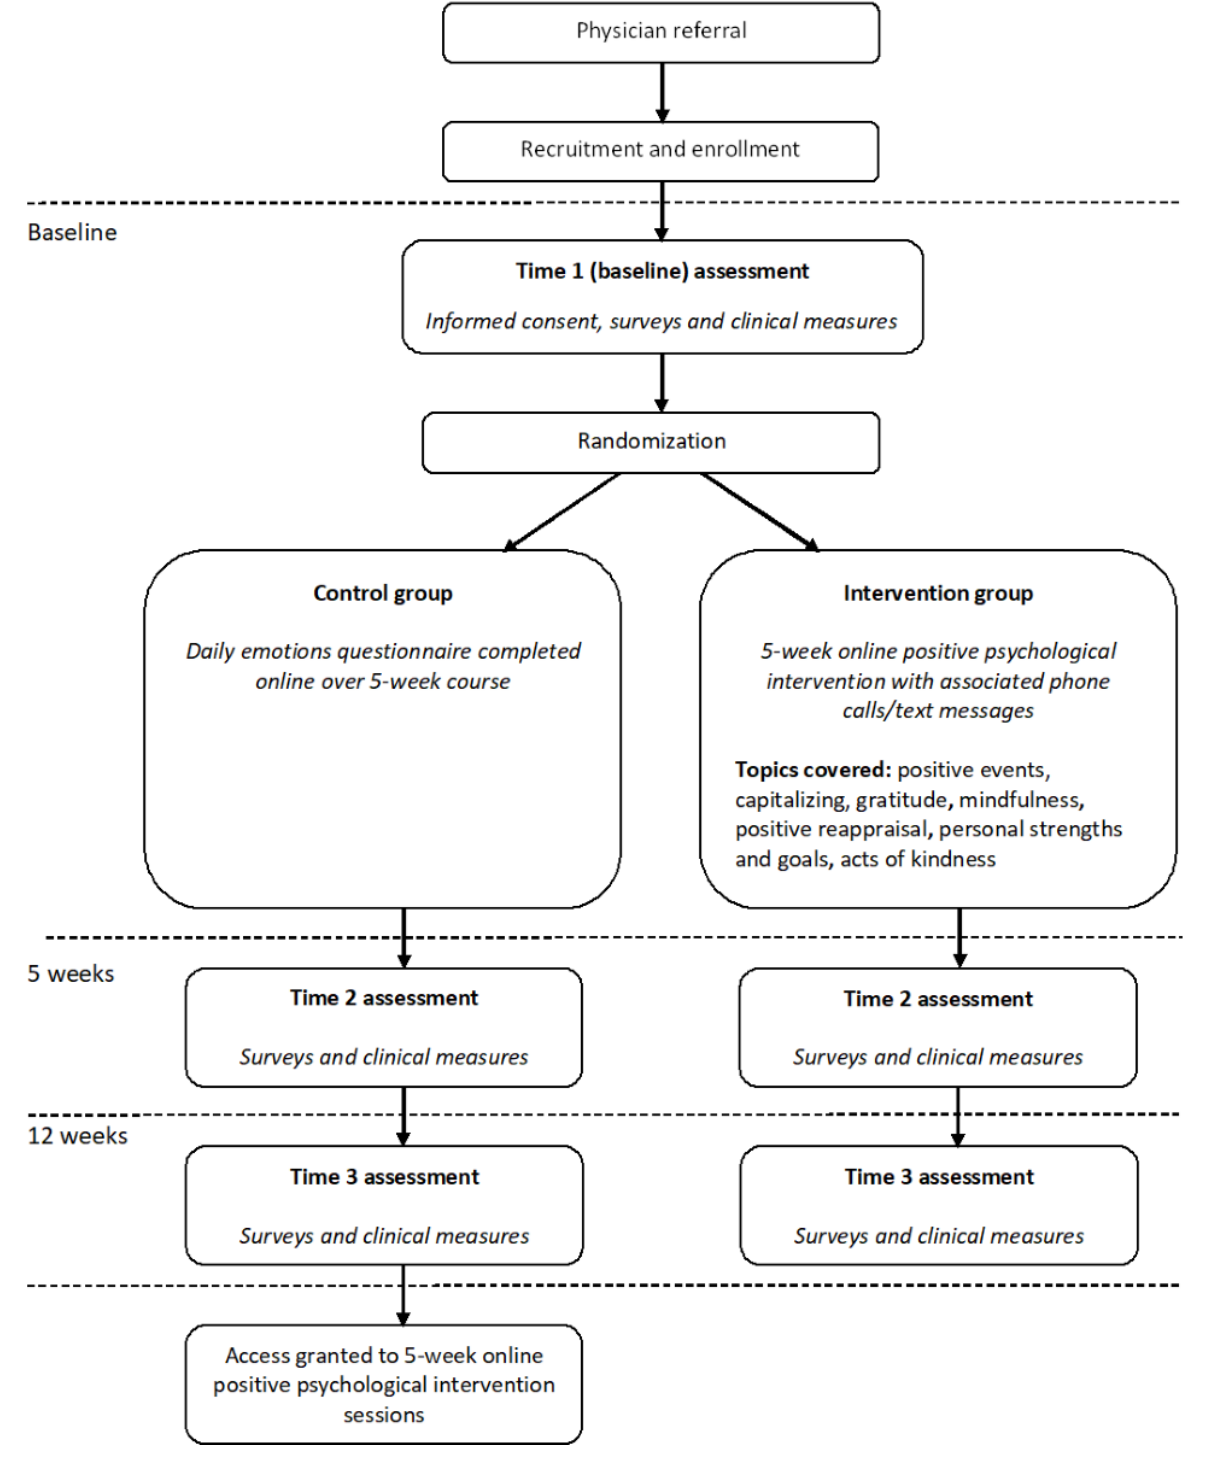
Figure 1. Recruitment and assessment timeline for the ¡Alégrate! web-based